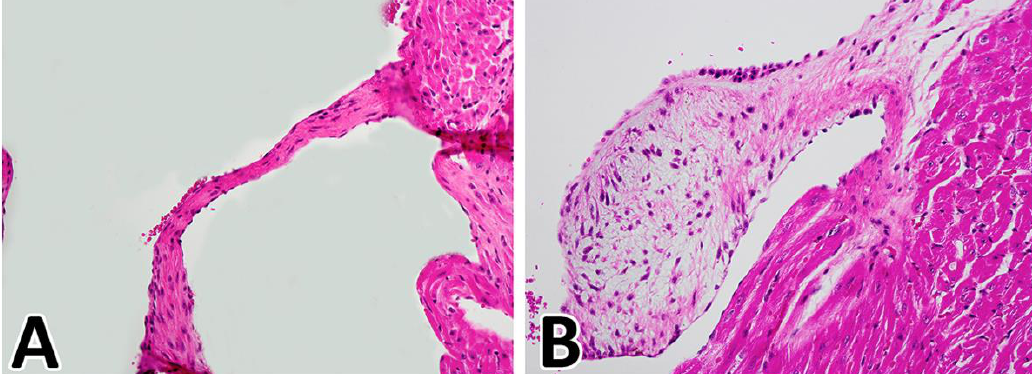
Figure 11. Myxomatous Valve Degeneration in the WT1 cre ;ALK3 fl/fl mouse. Panel ( A ) shows H/E staining of the posterior